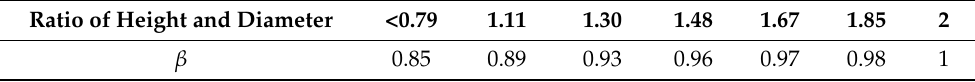
Table 5. Correction coefficient of specimen size for UCS.